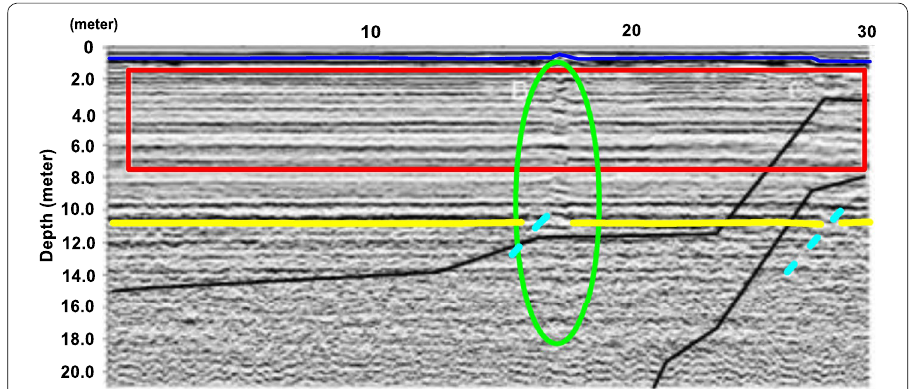
Fig. 22 GPR profile G6